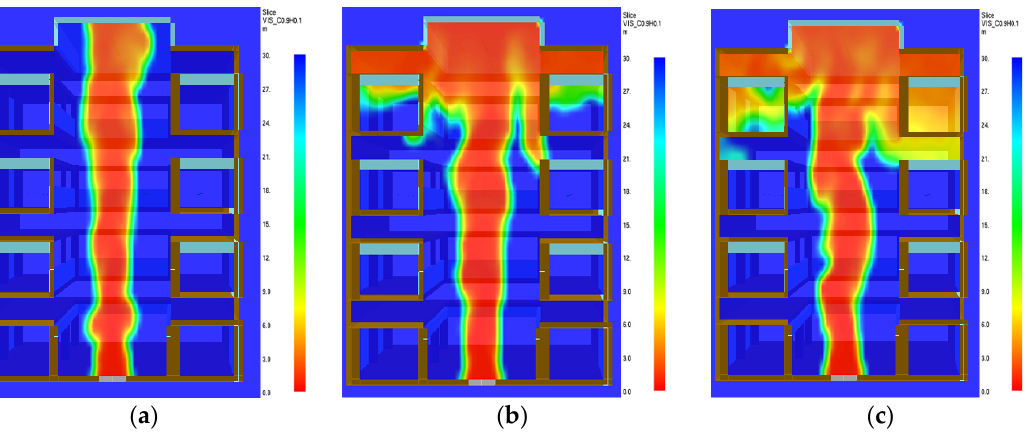
Figure 4. Diagram of the visibility inside the atrium at 30 s, 100 s and 300 s of the fire. ( a ) 30 s ( b ) 100 s ( c ) 300 s. ( c ) 300